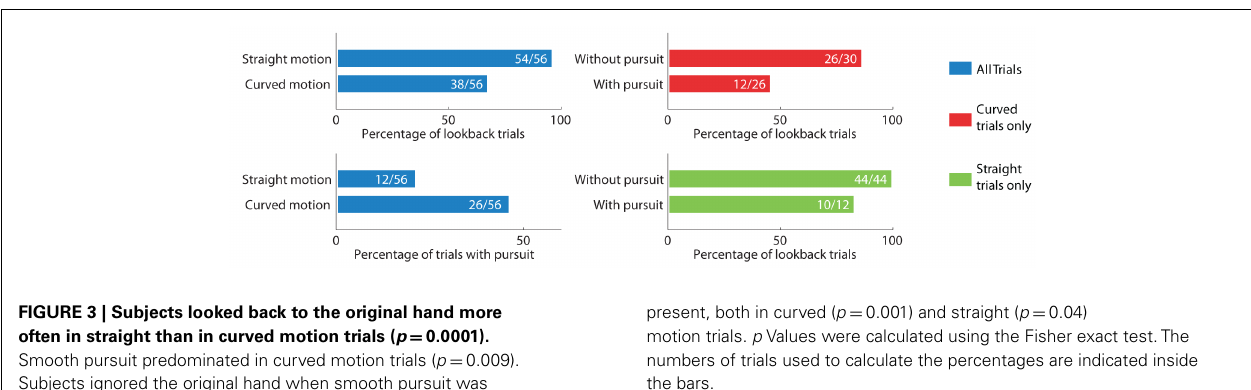
present, both in curved ( p = 0.001) and straight ( p = 0.04) motion trials. p Values were calculated using the Fisher exact test.The numbers of trials used to calculate the percentages are indicated inside the